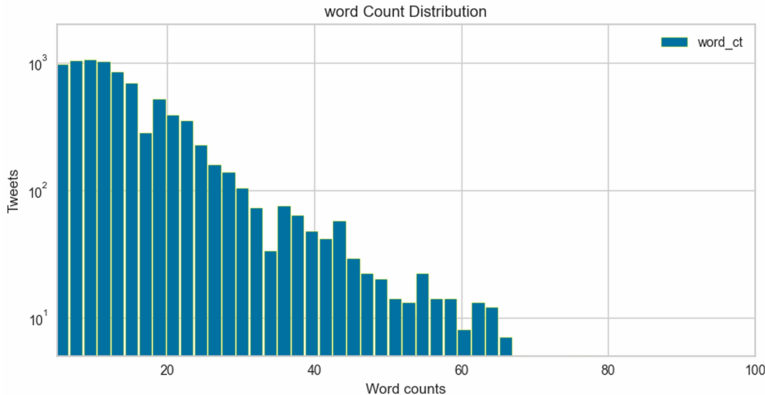
Figure 9. Word count distribution for non-cyberbullying